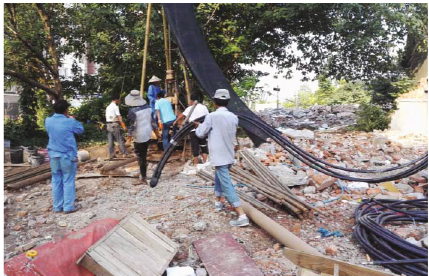
Figure 5: Installation of vertical heat